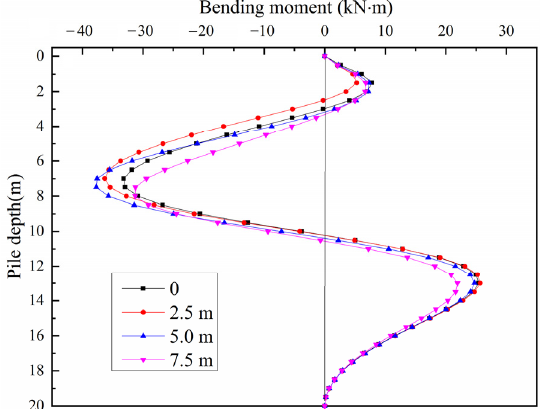
Figure 19. Influence of the pre-drilling depths of the new pile on the bending moment of the used pile.